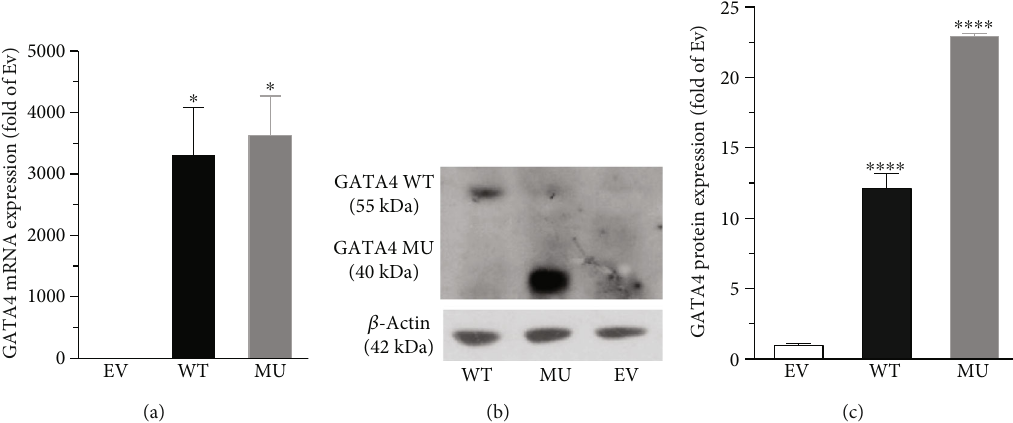
Figure 1: The transfection of plasmids pcDNA6-GATA4-WT and pcDNA-GATA4-MU. (a) QRT-PCR results demonstrated the successful transfection and expression of GATA4 mRNA in RCSMCs. One-way ANOVA, ∗ P < 0 : 05 versus EV, n = 3 . (b) Western blot results showed the expression of GATA4 in WT group (55 KDa) and MU group (40 KDa, truncated form). (c) Semiquantitative analysis of Western blot results. One-way ANONA, ∗∗∗∗ P < 0 : 0001 versus EV, n = 3